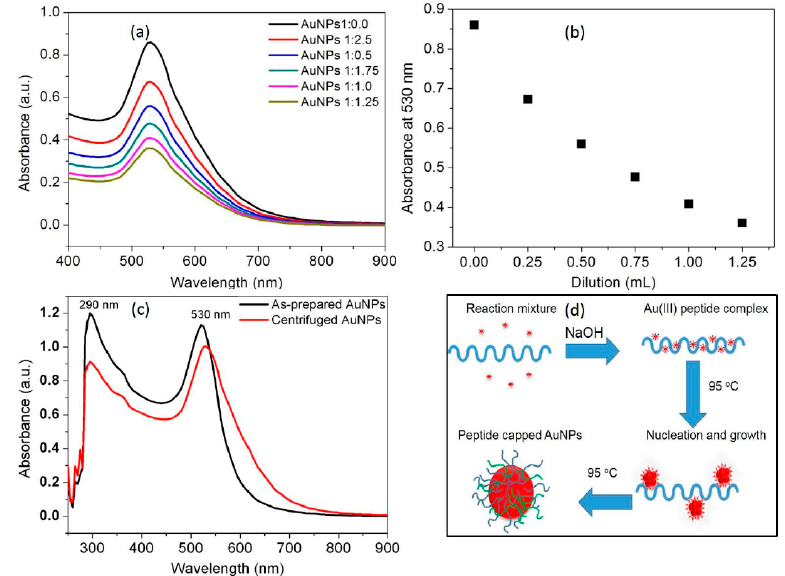
Figure 1. ( a ) Change in the plasmon absorption spectrum of the AuNPs under various dilution conditions by using distilled water; ( b ) A Beers and Lambert linear fit plotted from the experimental data collected at 530 nm under various dilution conditions by using distilled water; ( c ) The UV-vis spectrum of both as-prepared and centrifuged AuNPs in the UV range showing healthy capping of casein peptides on the AuNPs surfaces; ( d ) Schematic representation of casein peptide mediated synthesis and capping of the AuNPs.